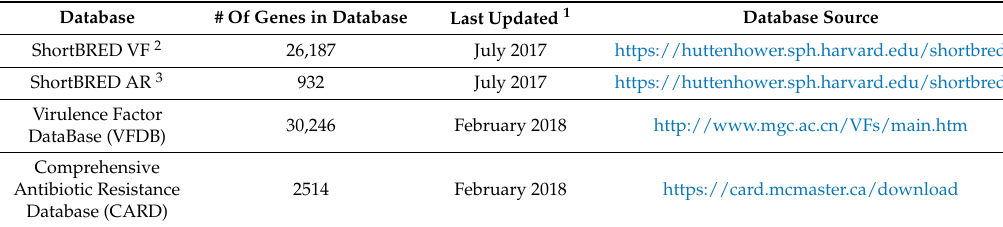
Table 1. Databases curated with virulence factor and antimicrobial resistance